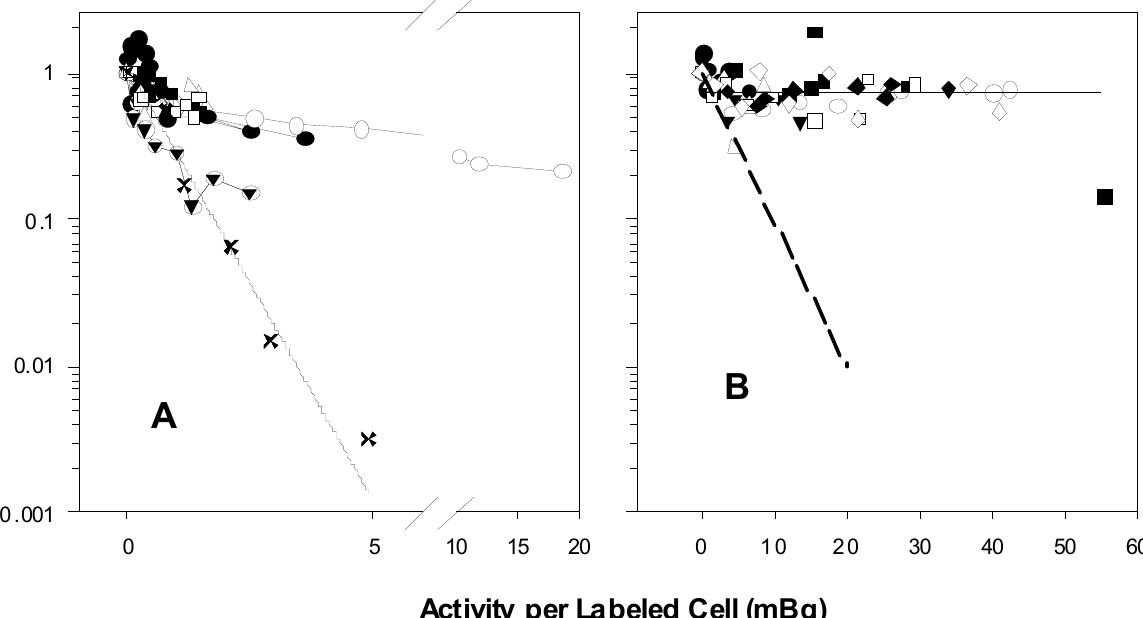
Activity per Labeled Cell